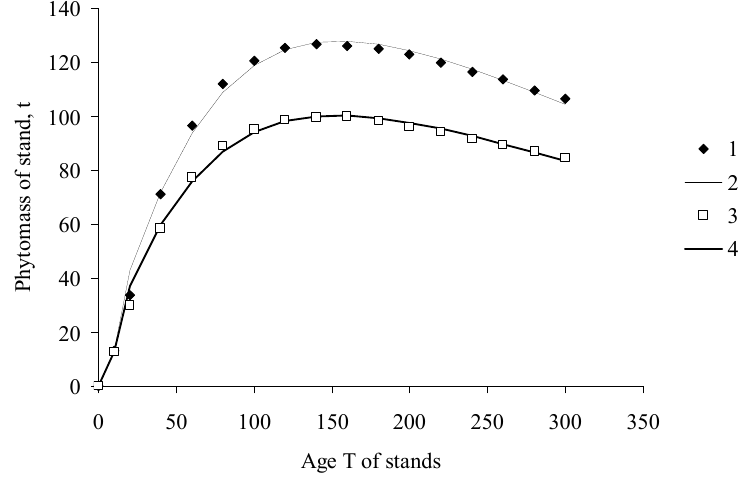
Figure 1. Phytomass of pine stands. ( 1 ) inventory data, Middle Siberia; ( 2 ) calculation with the ESM; ( 3 ) inventory data, South Siberia; ( 4 ) calculation with the ESM; (calculations were based on the data of different authors systematized [10,11]).